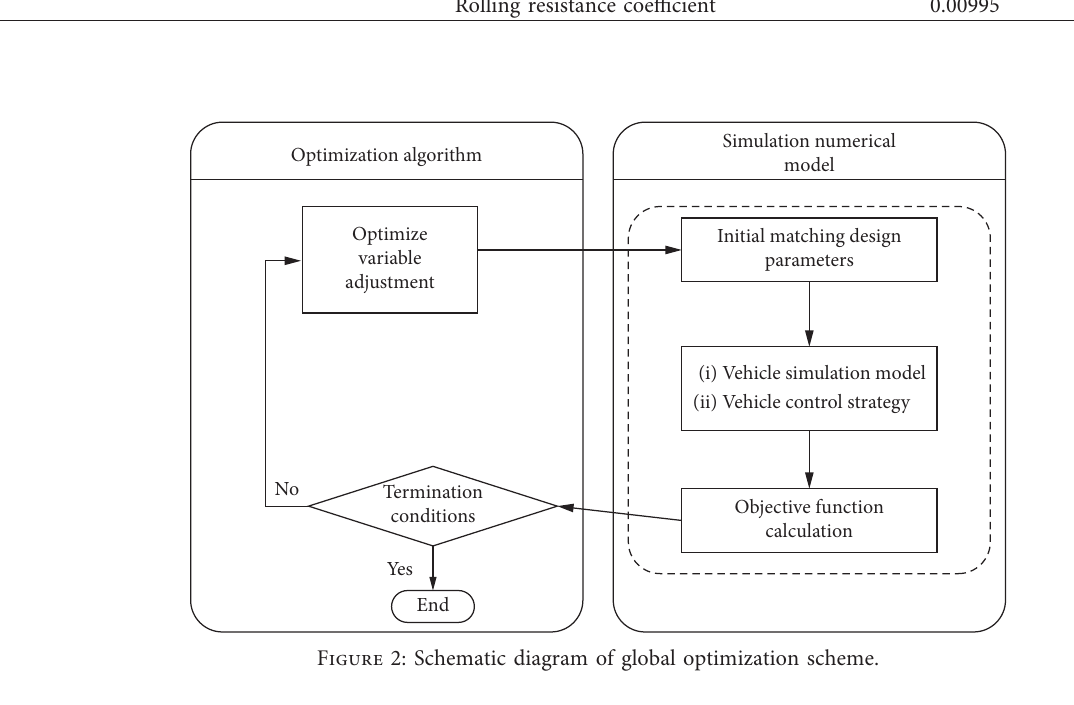
Figure 2: Schematic diagram of global optimization